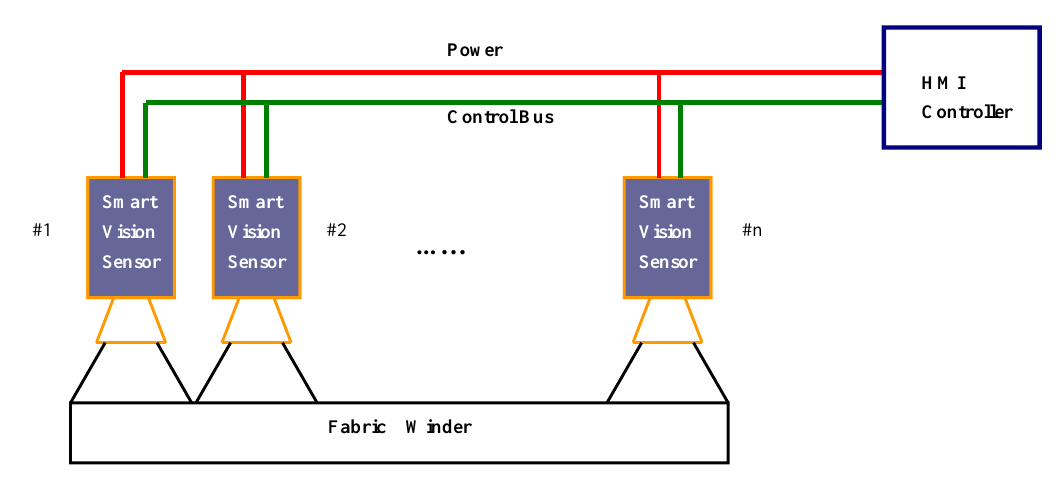
Figure 2. Automatic inspection system using smart visual